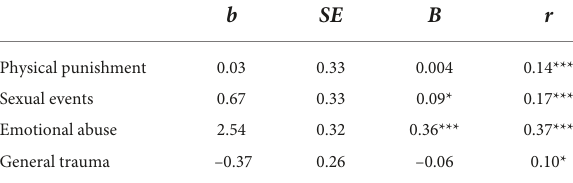
TABLE 3 Linear regression coefficients predicting young adult loneliness based on early life adverse events prior to the age of 18 years in Study 3.